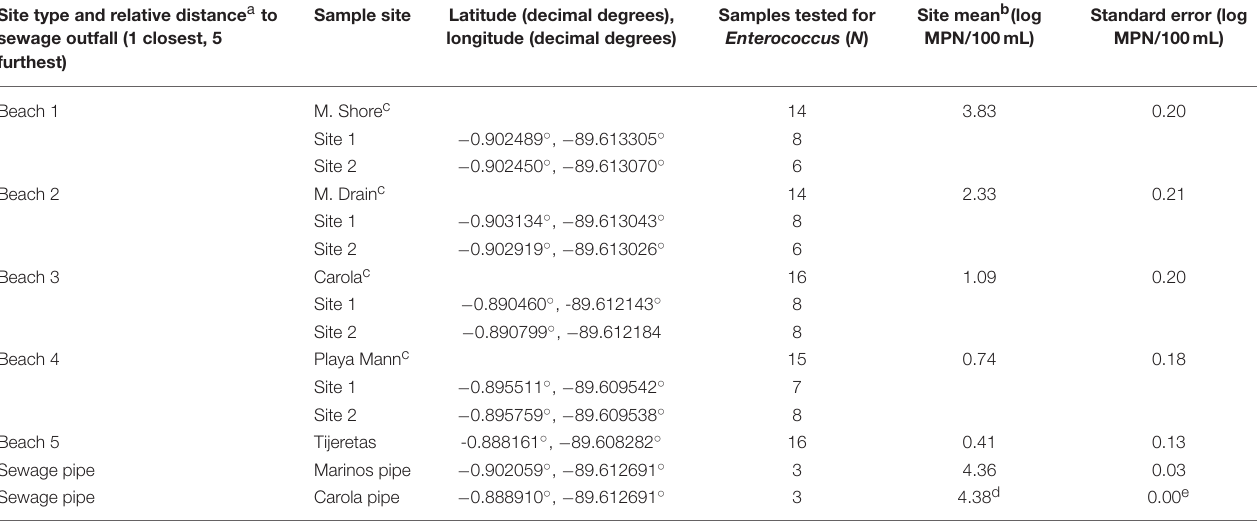
TABLE 1 | Enterococcus concentrations at each sample beach. Site type and relative distance a to sewage outfall (1 closest, 5